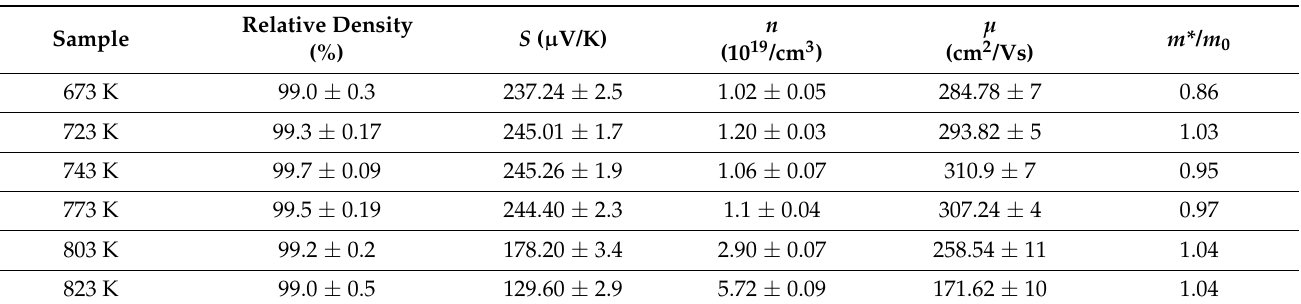
Table 2. The relative density, Seebeck coefficient ( S ), carrier concentration ( n ), mobility ( µ ), and carrier effective mass ( m* ) for the bulk